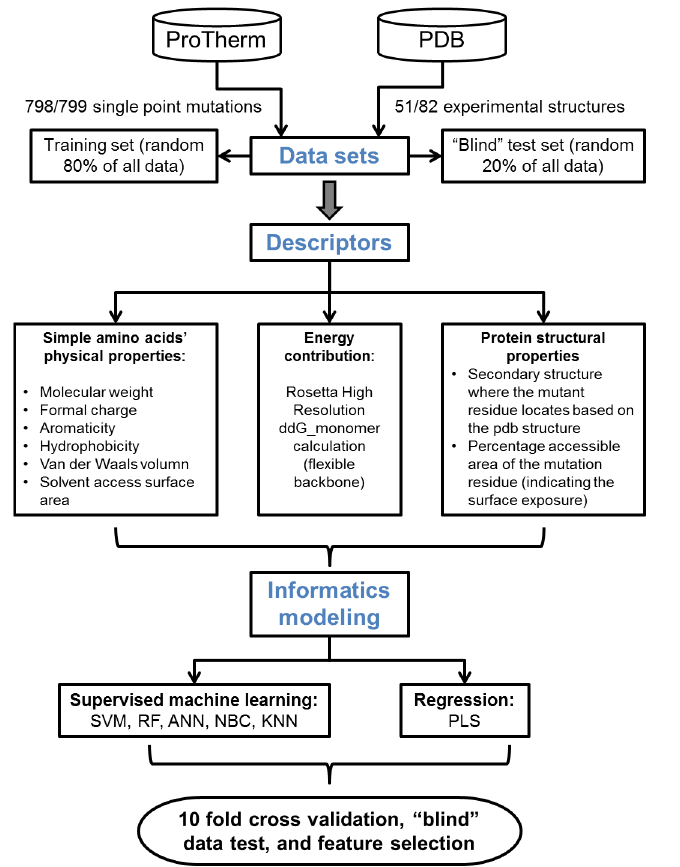
Fig 1. Workflow of model